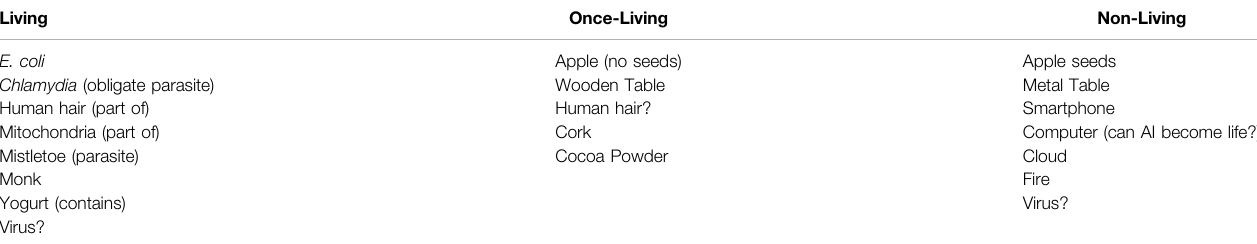
TABLE 1 | Typical table generated through class discussion to designate objects as “ living ” or “ non-living ” . To develop the following table, undergraduates were each given one word that they could not see and asked to guess the word using “ yes or no ” questions. The dif fi culty of placing certain items as “ living ” or “ non-living ” allows for